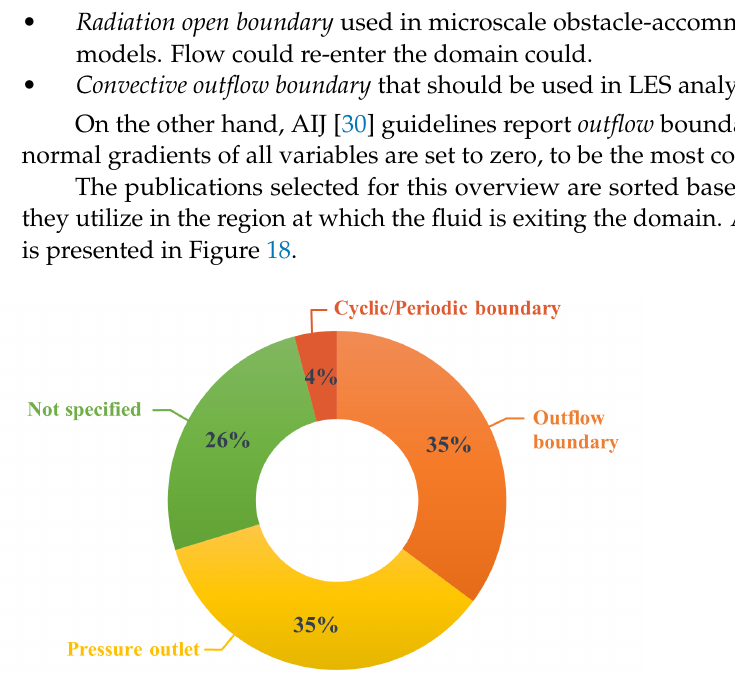
Figure 18. Outflow boundary